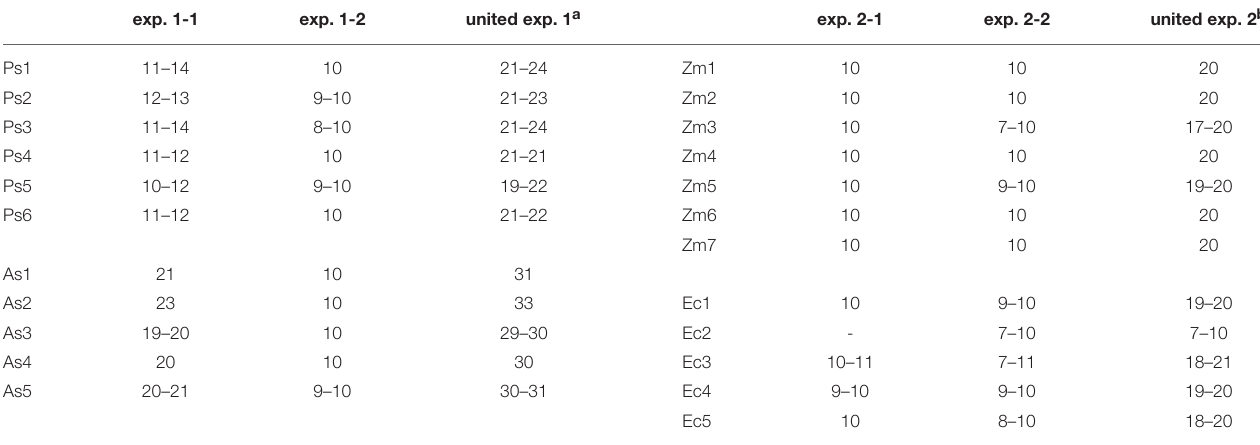
TABLE 2 | Sample size for each five Av-spectra of the different species, cultivars, provinces, and experiments. Ec2 in exp. 2-1 did not germinate. For each cultivar/provenience10 plants grew individually in pots. From each plant, one root was extracted to gain the five root segments. Over each root position the Av-spectra was averaged (see Figure 1 ). The exception was experiment 1-1, in several cases two roots were harvested which led to a higher sample size for the